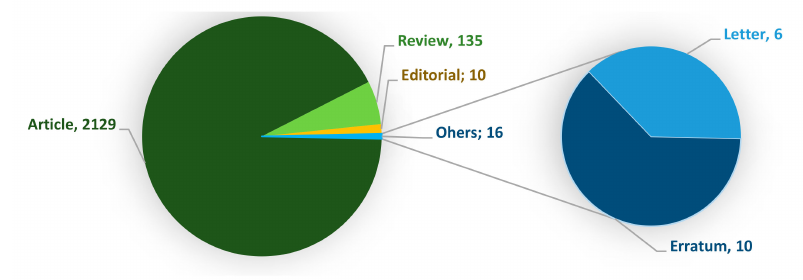
Figure 28. Distribution of journal Electronics publications according to document